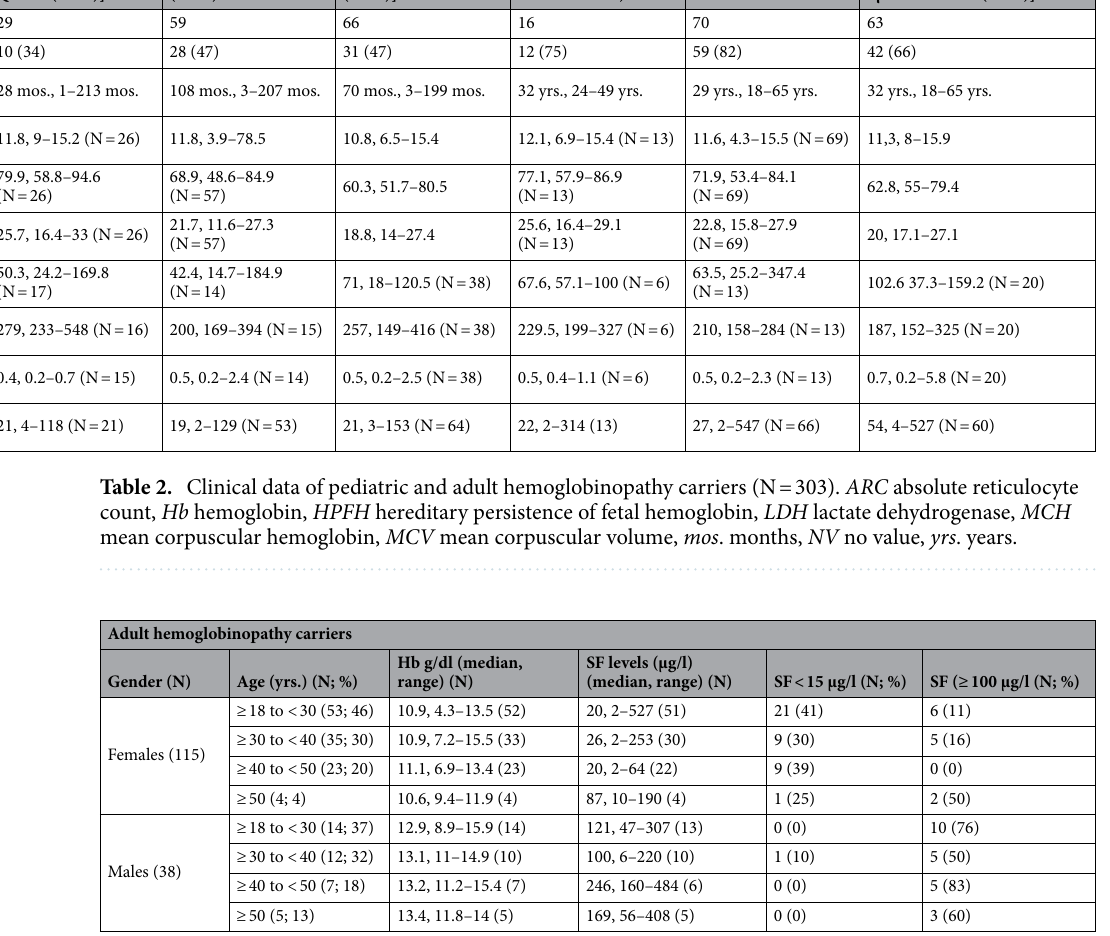
Table 3. Serum ferritin concentrations in adult hemoglobinopathy carriers (N = 153). Hb hemoglobin, SF serum ferritin, yrs . years.